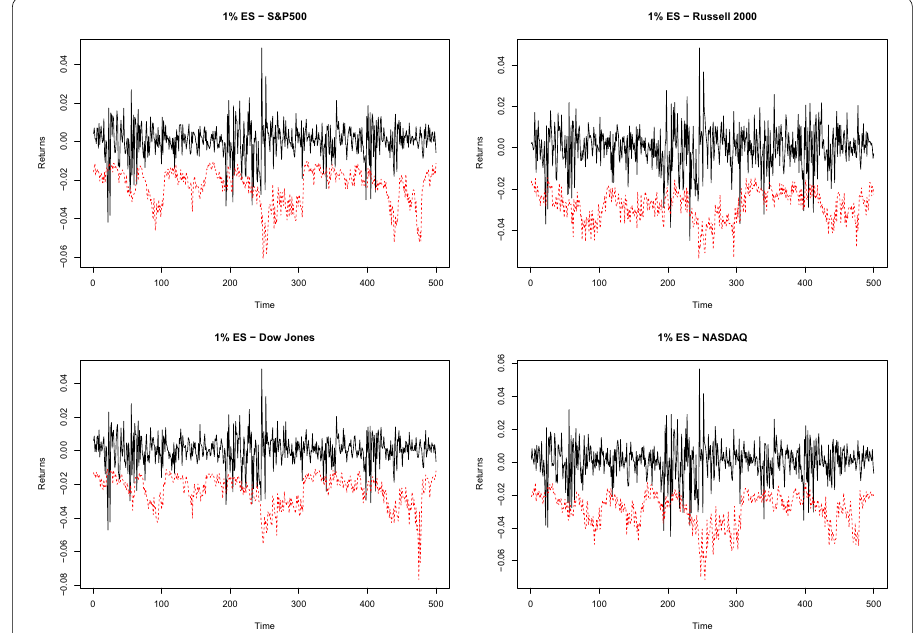
Fig. 5 Results for Model 3. The time series of returns is in solid (black) line and the one-step ahead forecasts ES are in dashed (red) line of −